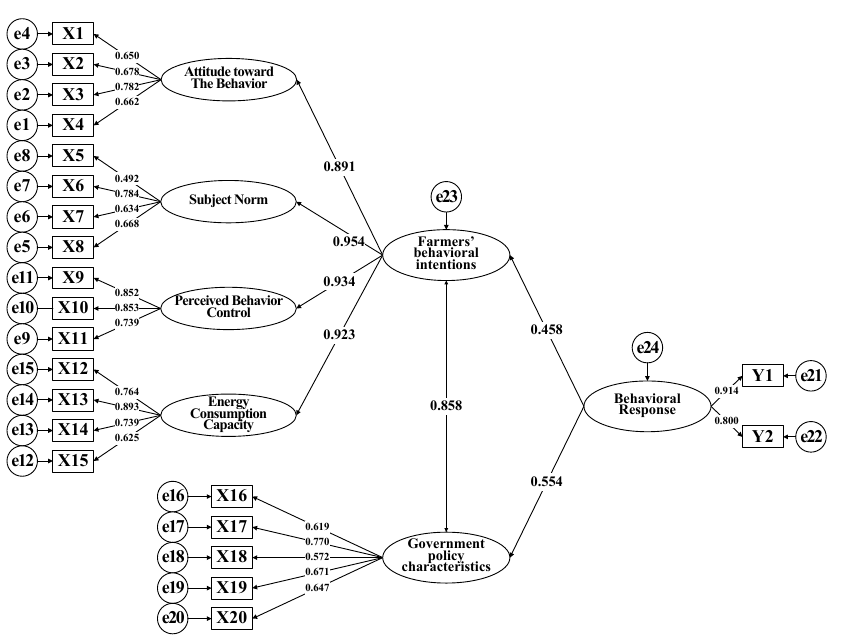
Figure 2. Structural equation model and normalized path coefficient diagram.